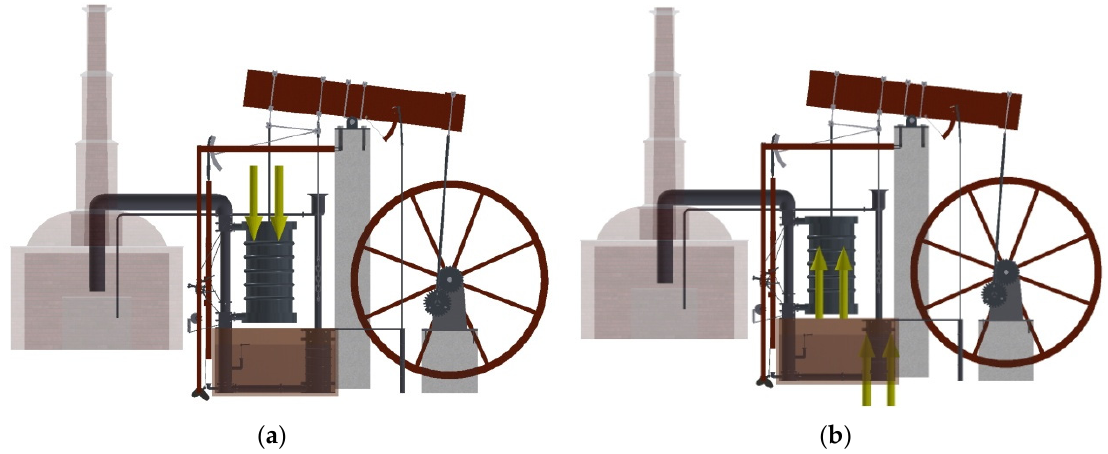
Figure 8. Force transmitted by the piston: ( a ) downward movement and ( b ) upward movement.